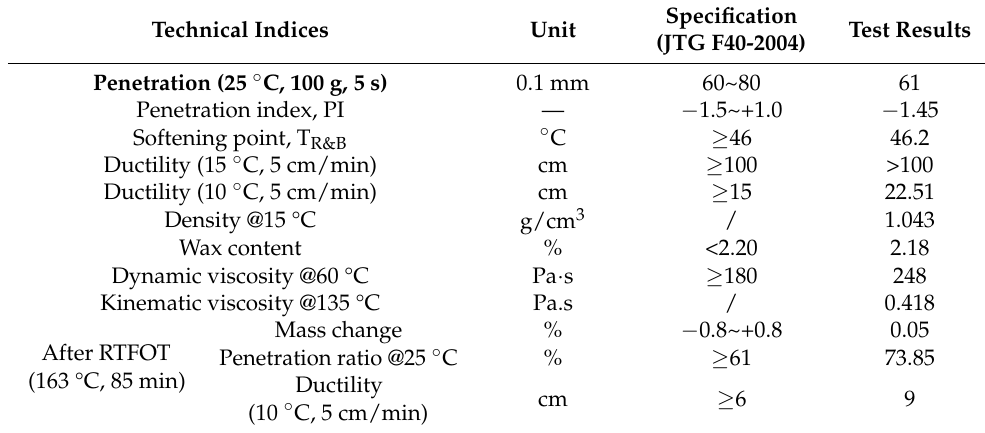
Table 1. Technical indexes of A-70# Petroleum